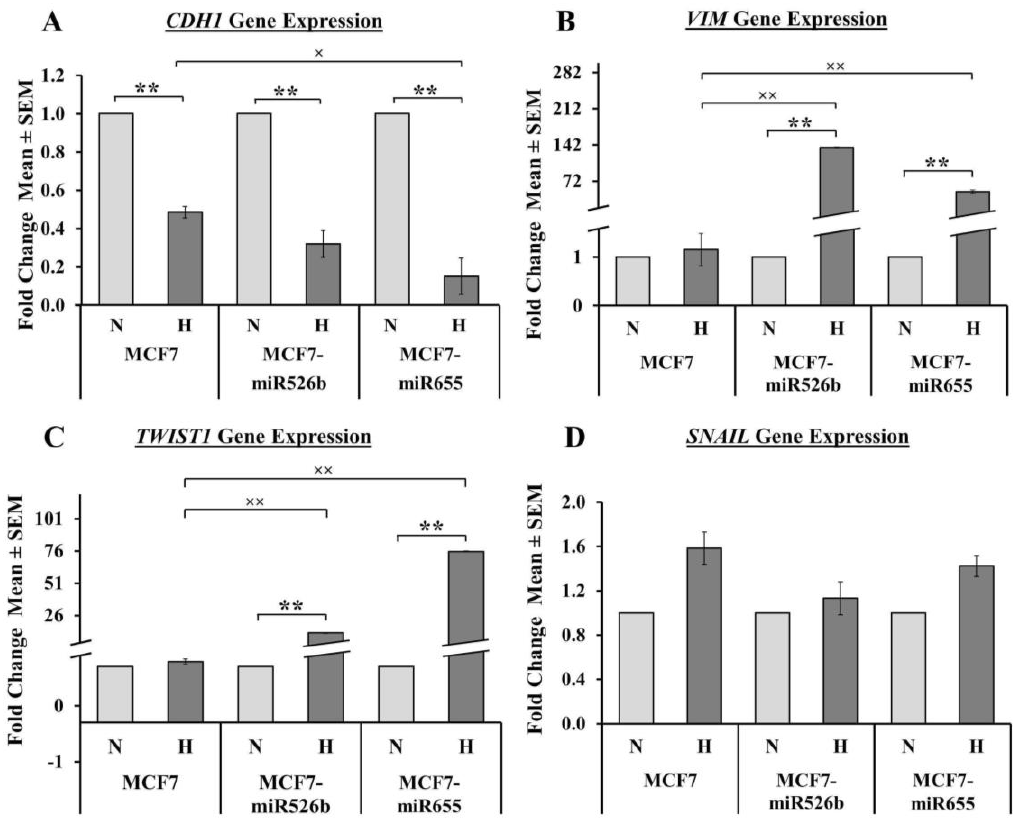
Figure 4. Expression of EMT markers in MCF7, MCF7-miR526b, and MCF7-miR655 cell lines: ‘N’ indicates normoxia, and ‘H’ indicates hypoxia. ( A ) Epithelial marker CDH1 gene expression. ( B ) Gene expression of mesenchymal marker VIM . ( C ) Gene expression of mesenchymal marker TWIST1 . ( D ) Gene expression of mesenchymal marker SNAIL . Data are presented as the mean ± SEM of quadruplicate replicates; ** p < 0.001, x indicates p < 0.05 and xx indicates p < 0.001. * Also indicates comparison between normoxia and hypoxia of the same cell line and x, indicates comparison between cell lines only in a hypoxic condition.